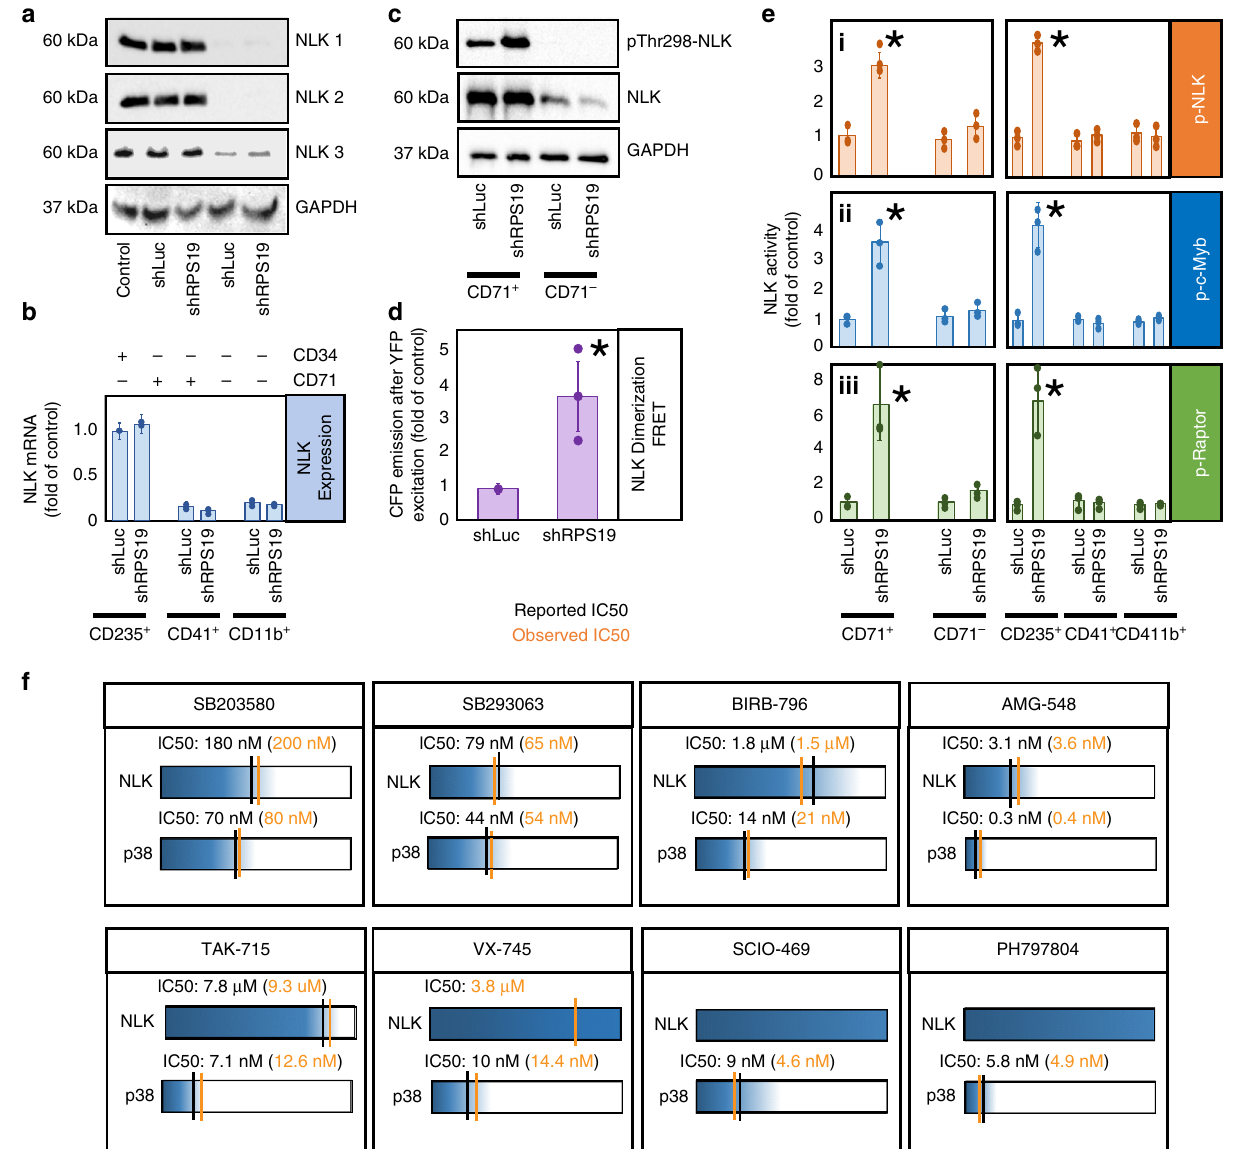
Fig. 3 NLK expression is higher in erythroid progenitors and is activated in RPS19-insuf fi ciency. a Transduced CD34 + CB HSPCs were differentiated for 10 days and CD71 + and CD71 – fractions were probed by Western blot analysis for NLK using three different NLK antibodies. Equivalent protein was loaded between samples. b — blue Transduced progenitors were differentiated for 15 days and sorted for surface expression of CD235 + , CD41 + and CD11b + population NLK mRNA was assessed by qRT-PCR. c Control and shRPS19-transduced CB progenitors were differentiated for 10 days prior to separation into CD71 + and CD71 - populations and assessed for pThr298-NLK phosphorylation by Western blot analysis. d — purple CB CD34 + progenitors were transduced with shRNA against luciferase (shLuc) or RPS19 (shRPS19) along with CFP-NLK and YFP-NLK and differentiated for 10 days. NLK dimerization was quanti fi ed by FRET. e — left panel NLK was immunoprecipitated from transduced differentiating CD71 + and CD71 - populations after 10 days, and incubated in the presence of ATP, Mg 2 + and dephosphorylated NLK (i orange), c-Myb (ii — blue) and Raptor (iii — green) for 30 min at 37 °C. Phosphorylation was detected by a combination of anti - phosphoserine-HRP and anti-phosphothreonine-HRP antibodies, or mouse anti-phosphoserine and anti-mouse-HRP antibodies. e — right panel For comparison, NLK in vitro kinase activity was assessed from CD235 + , CD41 + and CD11b + populations enriched after identical treatments. f A panel of eight small molecule p38 inhibitors were titrated into in vitro kinase assays in the presence of activated NLK or p38 from stimulated Kp53A1 cells. The IC 50 for NLK and p38 for each compound was calculated. The data are represented diagrammatically with IC 50 values represented as vertical lines along a concentration gradient for NLK and p38. Kinase activity is represented as blue and the extent of inhibition is depicted in white. Our observed values (shown in orange) can be easily compared with documented IC 50 values (shown in black) for each compound against each kinase. Bars represent means± SD with individual data points overlaid. n = 3 independent experiments performed in triplicate.Statistics: two- tailed Student ’ s t test, signi fi cant * p < 0.05. Also see Supplementary Figs. 3 and 4. Source data are provided as a Source Data fi defects of DBA when differentiated in vitro 27 . CB CD34 + cells c-Myb (ii), and Raptor (iii) and expression of NLK (iv), and were transduced with lentivirus expressing GFP and shRNA RPS19 or RPL11 (v). We observed a mild increase in in vitro against RPS19, RPL11, or control (luciferase). Cells were col- phosphorylation of all three substrates at day 3 in control cells lected each day and assayed for NLK activity against NLK (i), (Fig. 4a.i – iii), indicating a transient activation of NLK in